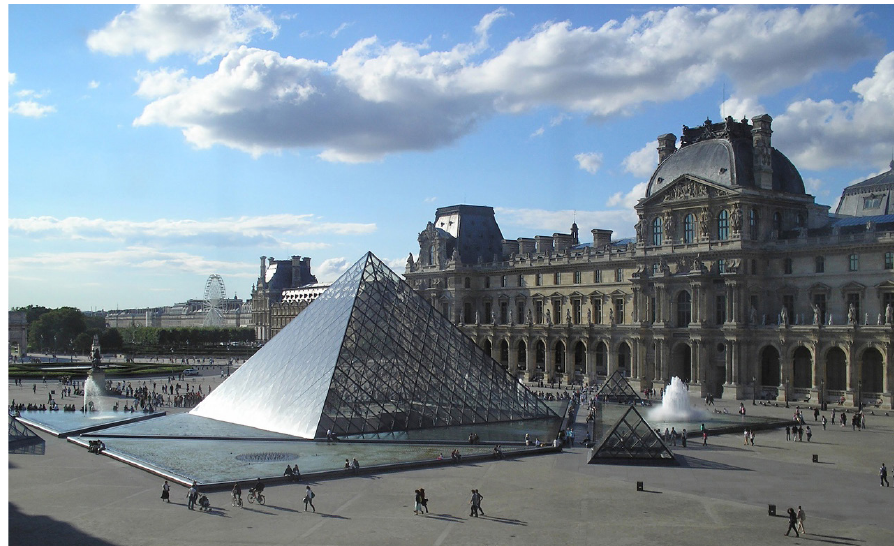
Figure 10. Dialogue of epochs in a historic urban environment. Reconstruction of the Louvre by Ieoh Ming Pei, 1989 (source: author,